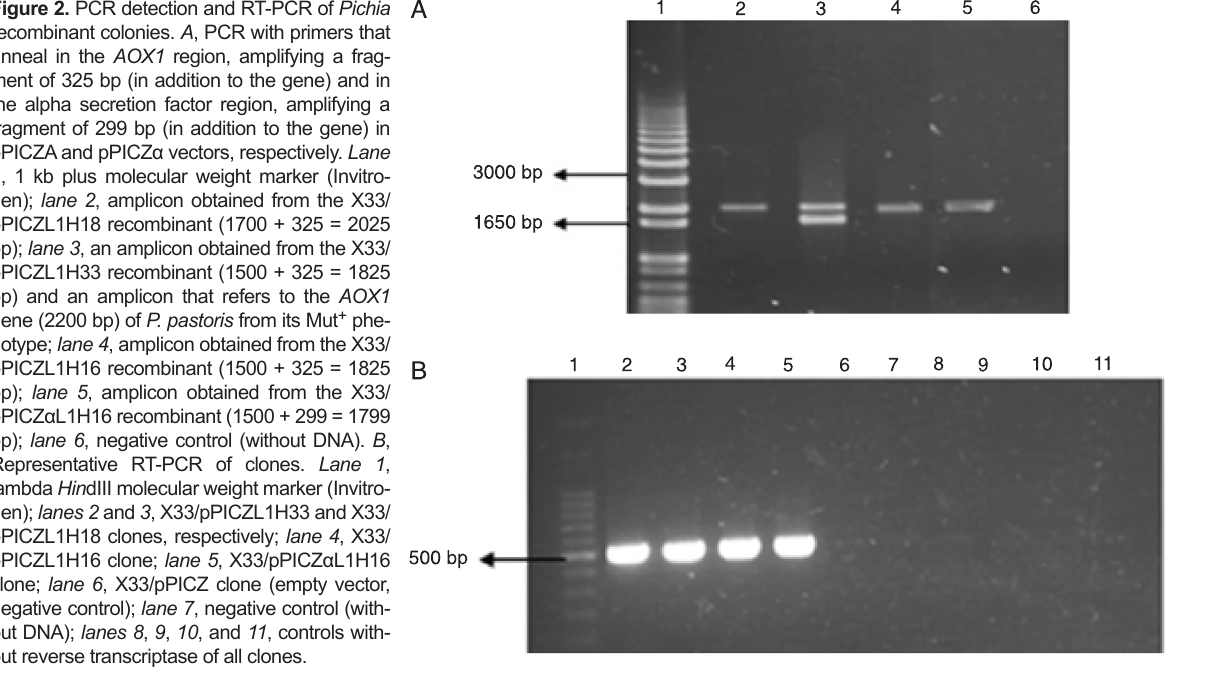
Figure 2. PCR detection and RT-PCR of Pichia recombinant colonies. A , PCR with primers that anneal in the AOX1 region, amplifying a frag- ment of 325 bp (in addition to the gene) and